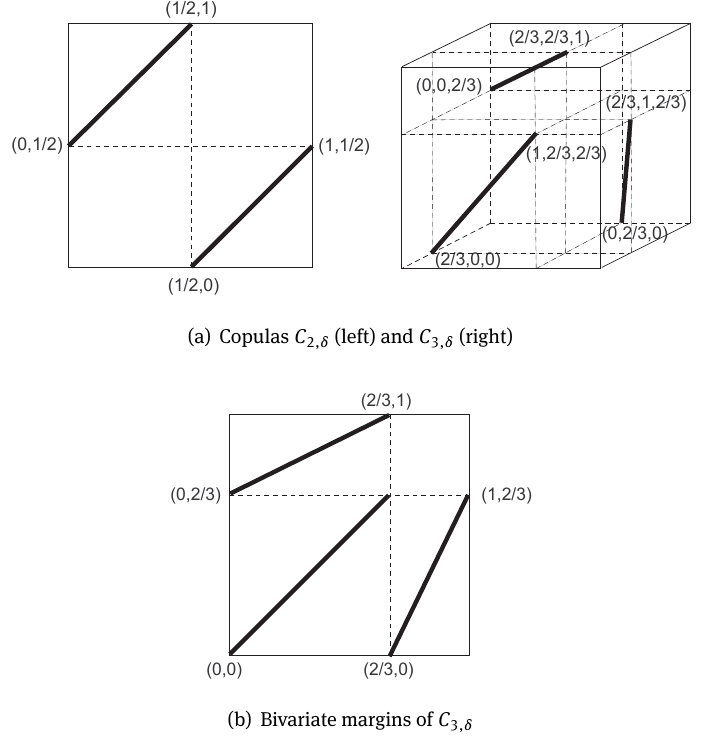
Figure 1: In (a) the supports of the copulas C 2, δ and C 3, δ , and in (b) the support of the bivariate margins of C 3, δ of Example